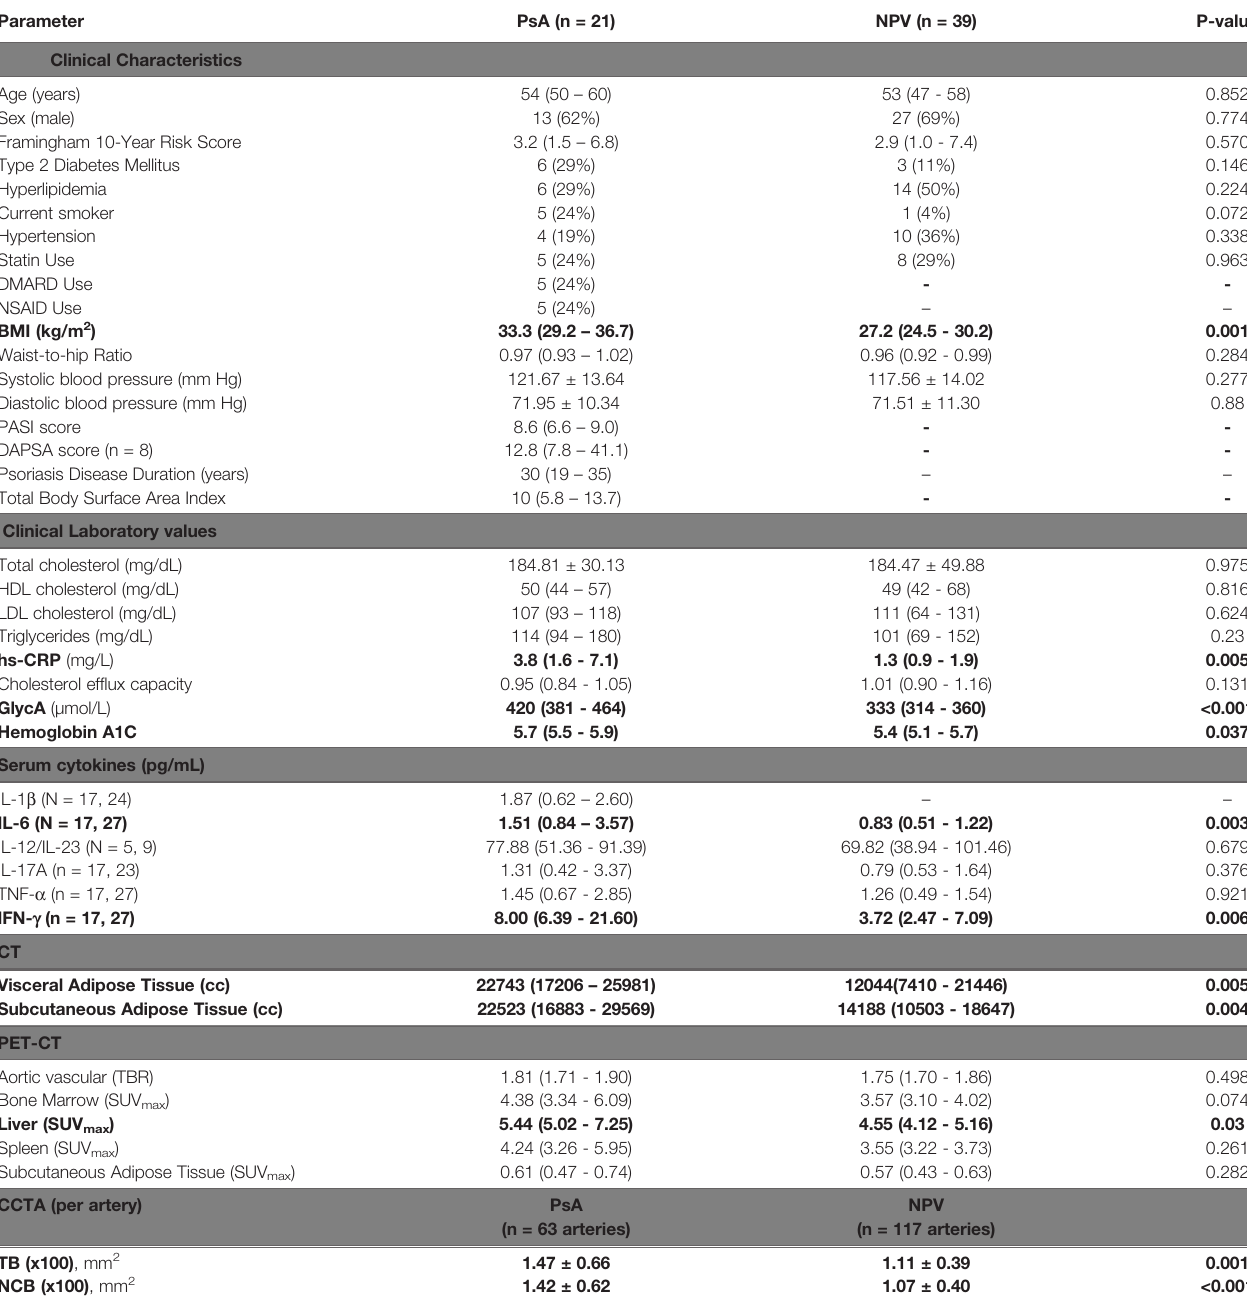
TABLE 1 | Clinical, laboratory, immunological and imaging characteristics of biologic naïve subjects with PsA and moderate to severe skin disease (PASI > 6) and non- psoriatic volunteers.